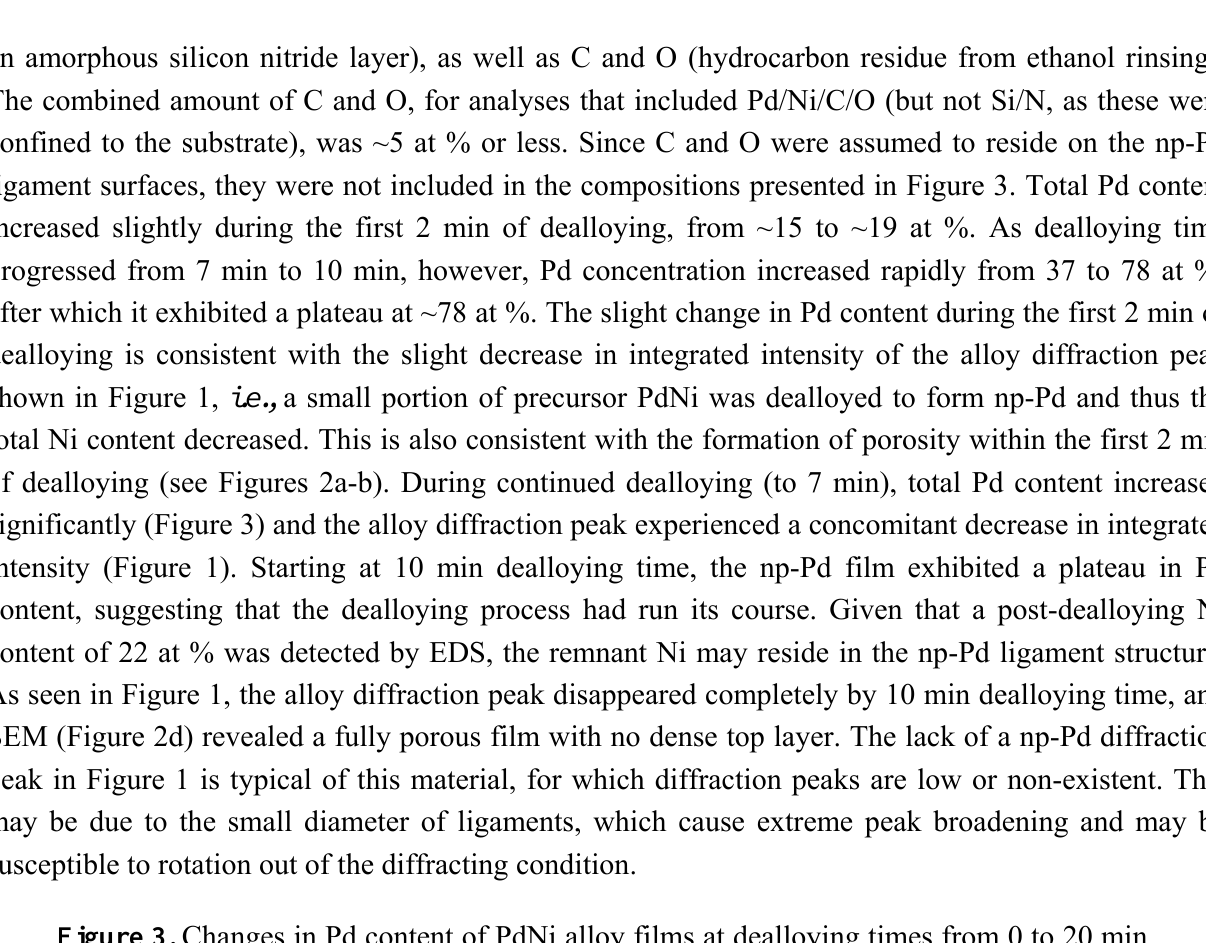
Figure 3. Changes in Pd content of PdNi alloy films at dealloying times from 0 to 20 min. Pd content increases rapidly between 7 and 10 min dealloying time, and exhibits a plateau at ~78 at % beyond this